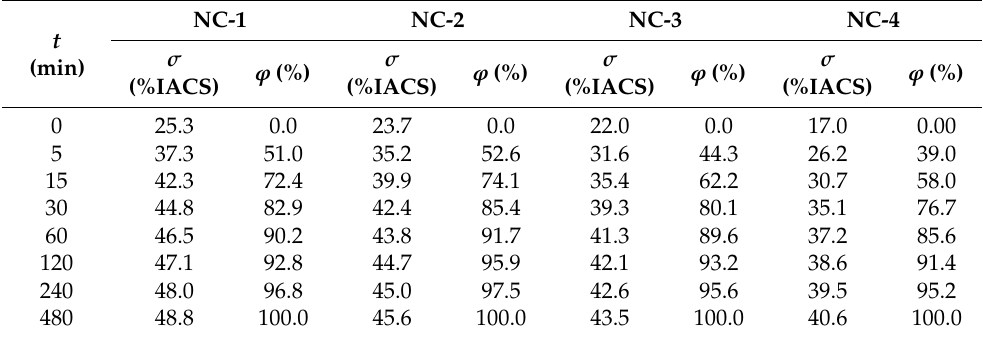
Table 7. Conversion rate and corresponding conductivity of alloys aged at 500 ◦ C for different times.